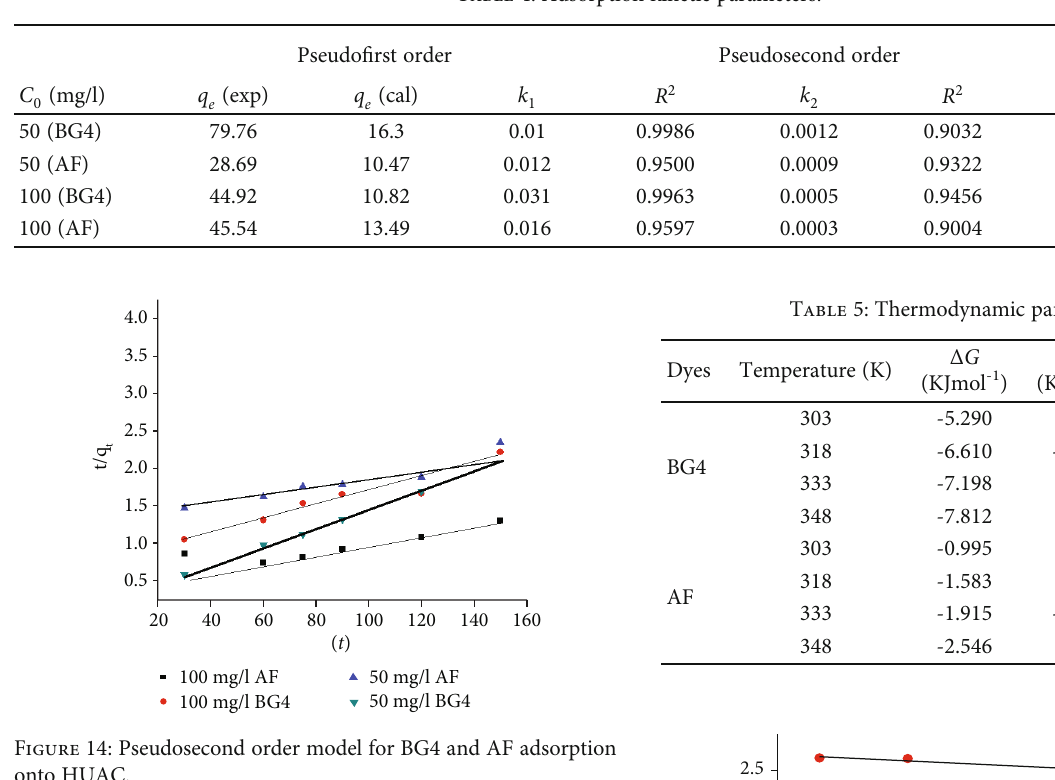
Table 4: Adsorption kinetic parameters.